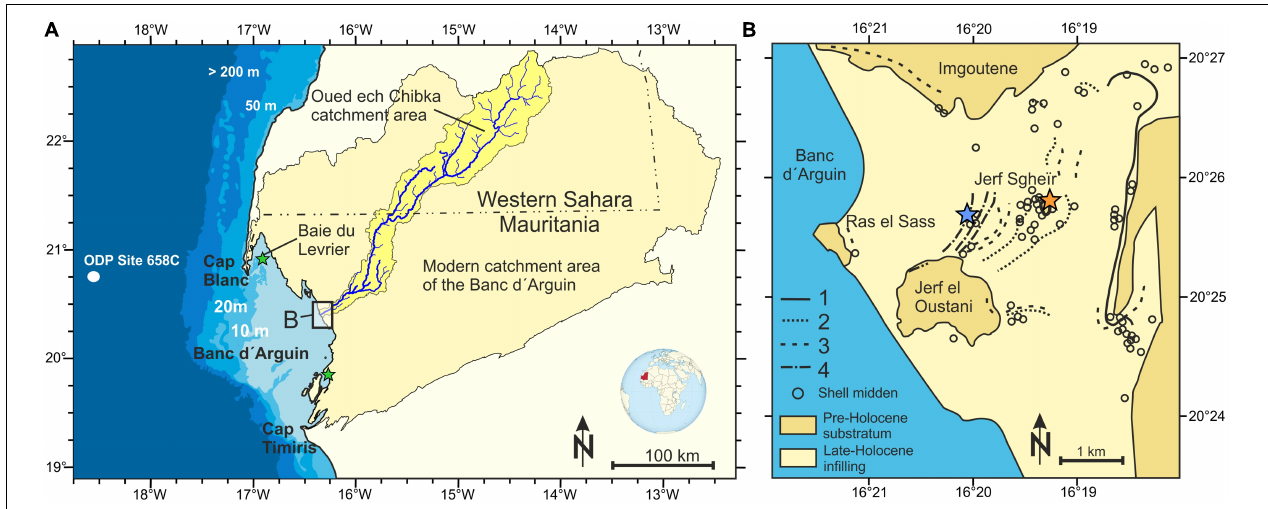
FIGURE 1 | Research area at Banc d’Arguin, Mauritania, NW Africa. (A) NW African coastline bathymetry with the shallow Banc d’Arguin, and the modern catchment area draining into the Banc d’Arguin. Approximate sample locations of modern catfish otoliths (Baie du Lévrier) and bivalve shells (near Iwik, southern part of the Banc d’Arguin; see Lavaud et al., 2013 for details) are indicated by green stars. (B) Close-up of the study site in the hinterland of Ras el Sass in the mouth of a large palaeo-estuary (Skonieczny et al., 2015). The location of shell midden alignments and beach ridges show the human occupation pattern following the coastal progradation throughout the mid- to late Holocene: 1: > 5000 years BP according to archaeological evidence; 2: Jerf Sgheïr shell midden of this study (5320–5020 years BP); 3: Tintan group (4600–4000 years BP); 4: Last Neolithic groups (3300 years BP). Archaeological ages adapted from Barusseau et al. (2007). Approximate locations of mid-Holocene and late Holocene samples are indicated by orange and blue markers, respectively. The map and inlet map were created using the SRTM 1 Arc-Second (USGS, 2004) dataset (available at https://earthexplorer.usgs.gov/). The catchment area in A was calculated using the SCALGO